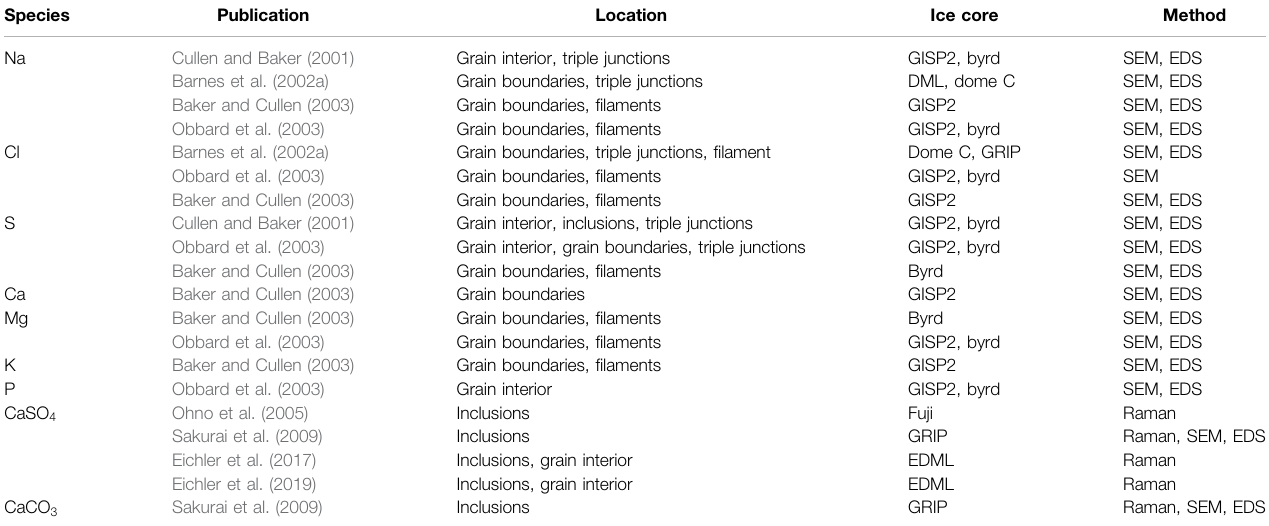
TABLE 2 | Outlook into a detailed open-access impurity data base.